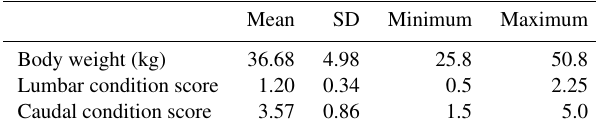
Table 2. Descriptive statistics for ewes’ body weight (BW), lumbar and caudal scores at